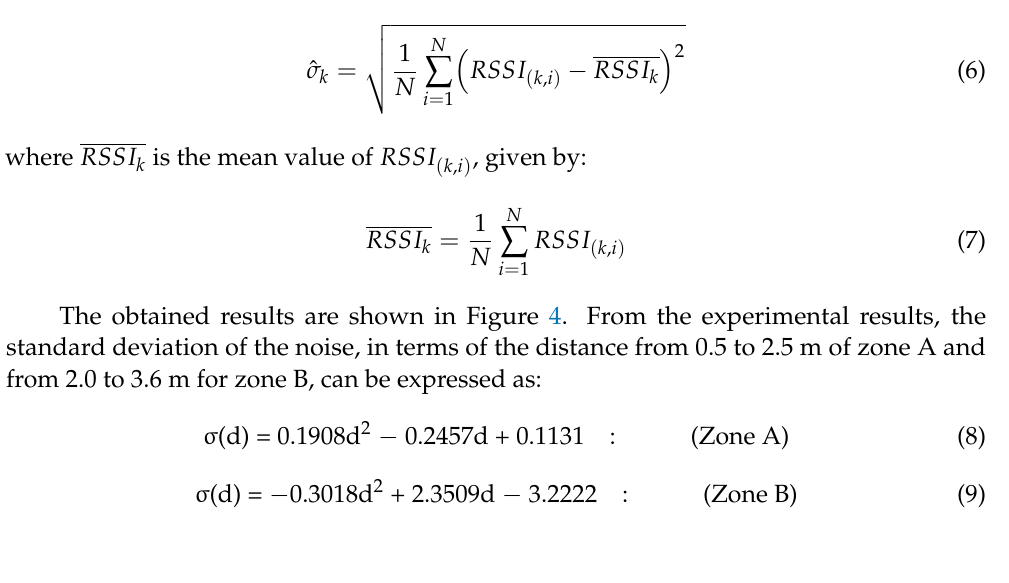
Figure 3. Relationship of measured RSSI values and distance of ( a ) Zone A and ( b ) Zone B. Meanwhile, the standard deviation of the noise for each distance can be estimated